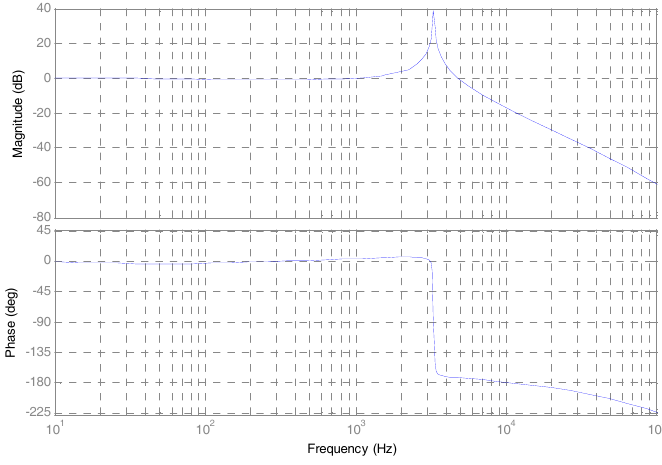
Figure 8. Closed-loop transfer function frequency response.